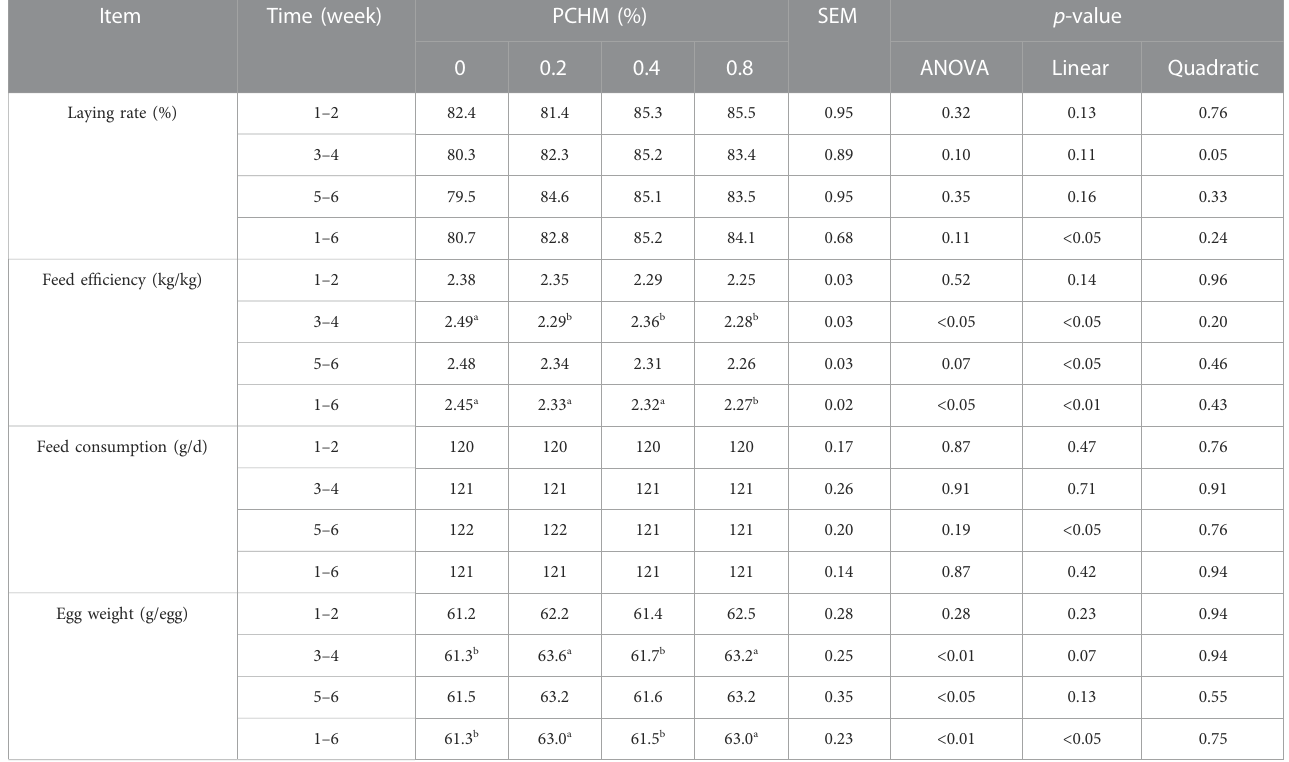
TABLE 5 Effect of dietary PCHM supplementation on performance.